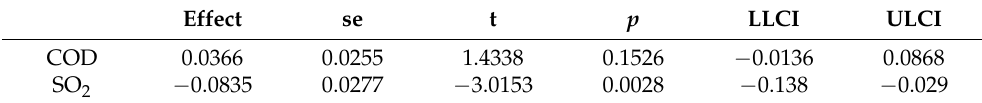
Table 8. Direct effect of Eco-province policy (after control mediating